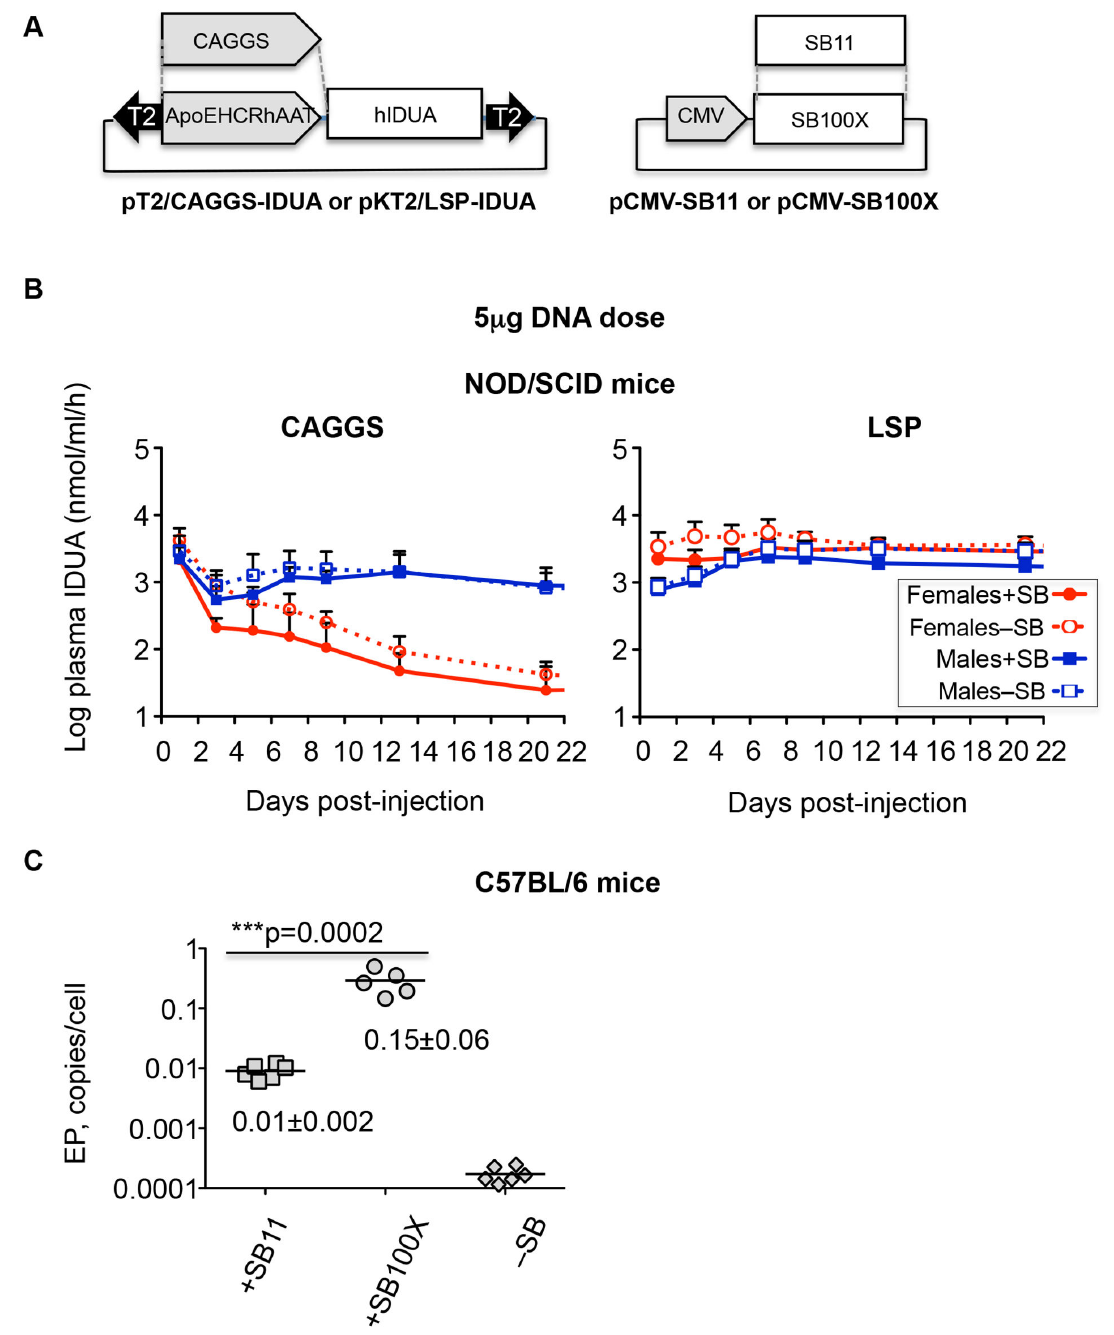
Figure 1. Expression of IDUA from different promoters in NOD/SCID MPS I mice. A . Vectors used in this study. The T2 SB transposon vectors (inverted arrowheads) contained either a “ubiquitous” CAGGS promoter or the liver-specific promoter (LSP) ApoEHCRhAAT. pKT2/ApoEHCRhAAT-hIDUA and pT2/miniCAGGS-hIDUA have different backbones and the selectable markers, ka n and amp , respectively. B . Kinetics of hIDUA expression from LSP and CAGGS promoters in NOD.129(B6)-Prkdc scid IDUA tm1Clk /J (NOD/SCID) mice. Symbols: +SB11 females, filled red circles and solid lines; –SB females, open red circles and dotted lines; +SB11 males, filled blue squares and solid lines; –SB males, open blue squares and dotted lines. Each point represents the mean hIDUA activity ± SD, n=6. The CAGGS graph in panel B , is from Figure 1d of [8]. C . Comparison of transposition efficiency of SB11 and SB100X transposases in C57BL/6 mice by the excision product (EP) assay. 2μg of either pCMV-SB11 or pCMV-SB100X transposase-encoding plasmid was co-delivered with 15μg of pT2/CAGGS-GUSB [7] transposon plasmid. DNA for excision assay was isolated from livers 5 days p.i. doi: 10.1371/journal.pone.0078161.g001 PLOS ONE |